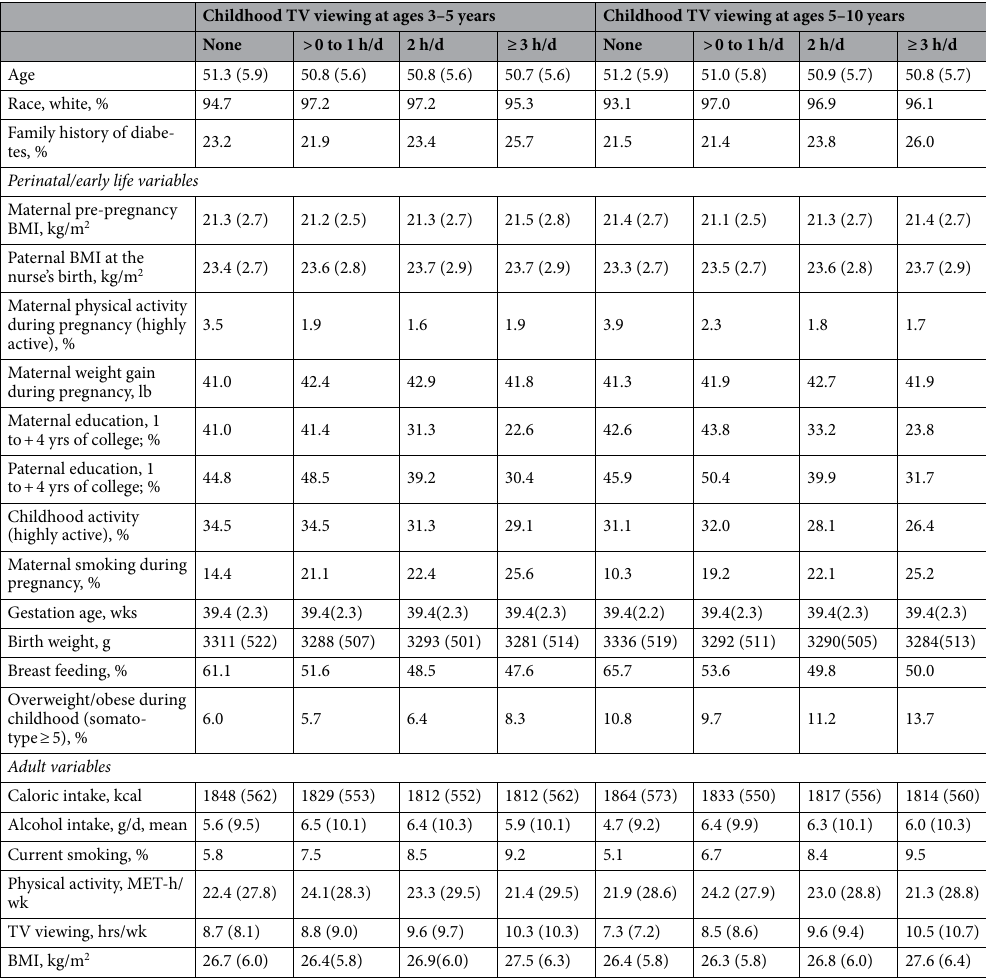
Table 1. Age-standardized characteristics of daughters of the Nurses’ Mothers’ Cohort according to television viewing at ages 3–5 and 5–10 years. Values are averages during follow-up. Values are means (SD) or percentages and are standardized to the age distribution of the study population (except age). TV television, BMI body mass